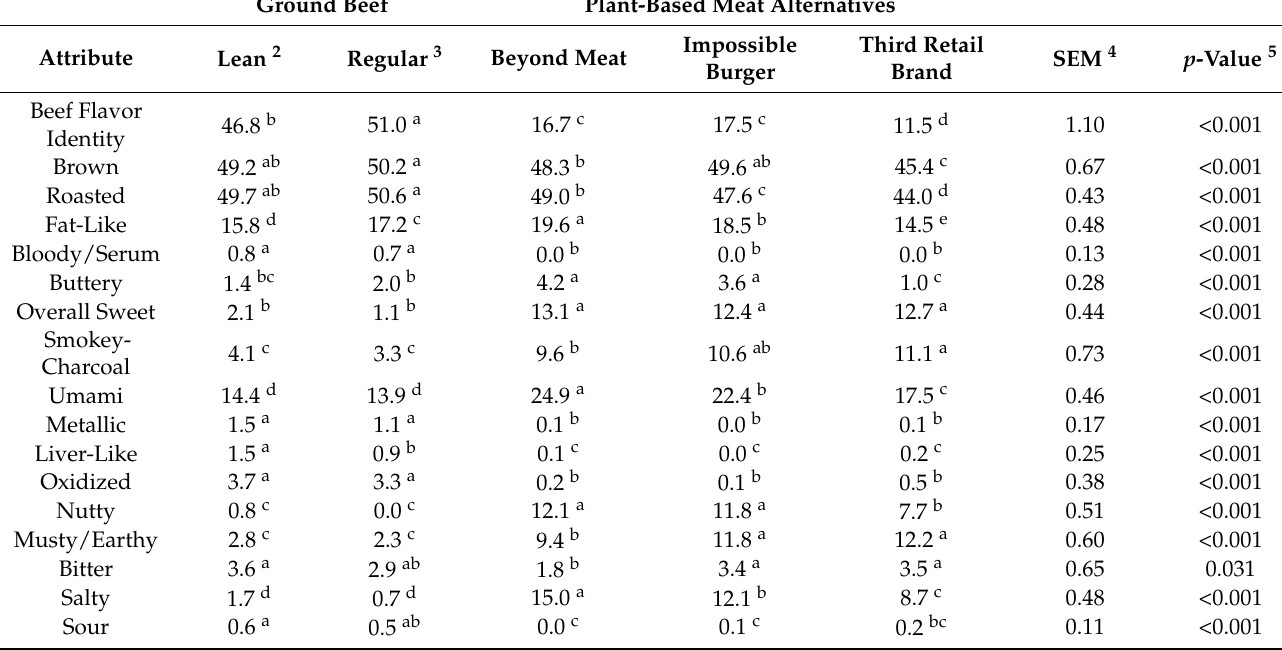
Table 1. Least squares means of descriptive flavor attributes 1 from three plant-based meat alternatives and two lean levels of ground beef.